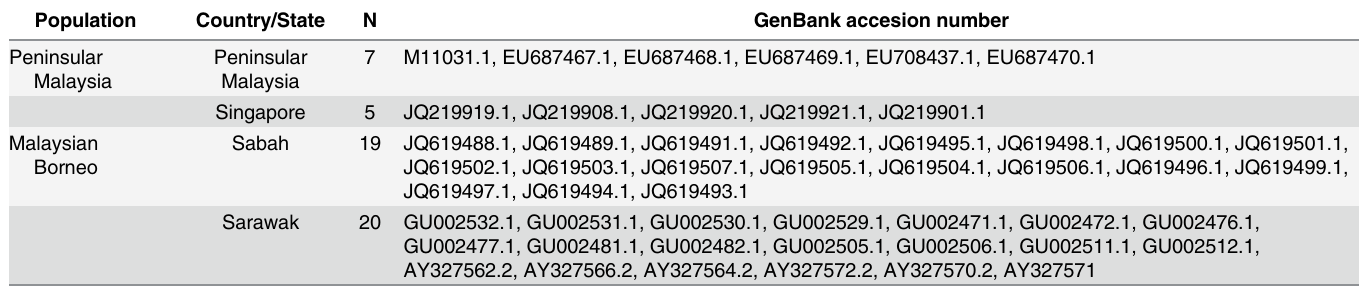
Table 1. Plasmodium knowlesi CSP genes from GenBank. N = total number of